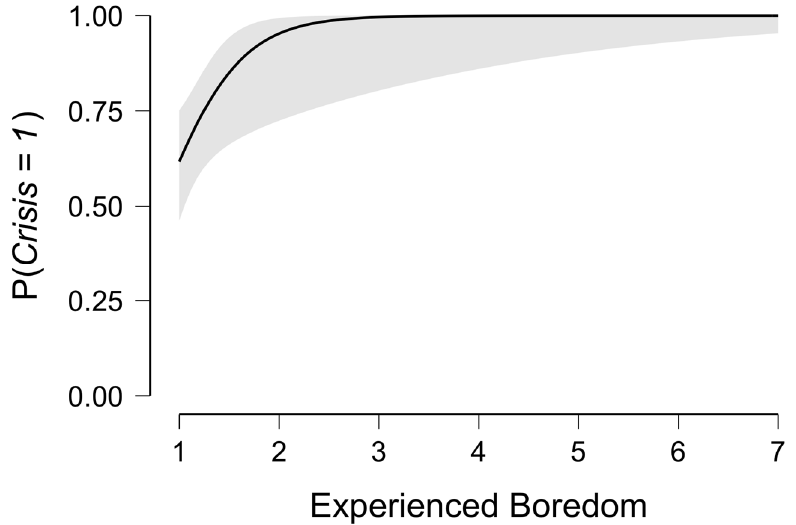
Figure 5. Boredom and probability of experiencing a crisis.